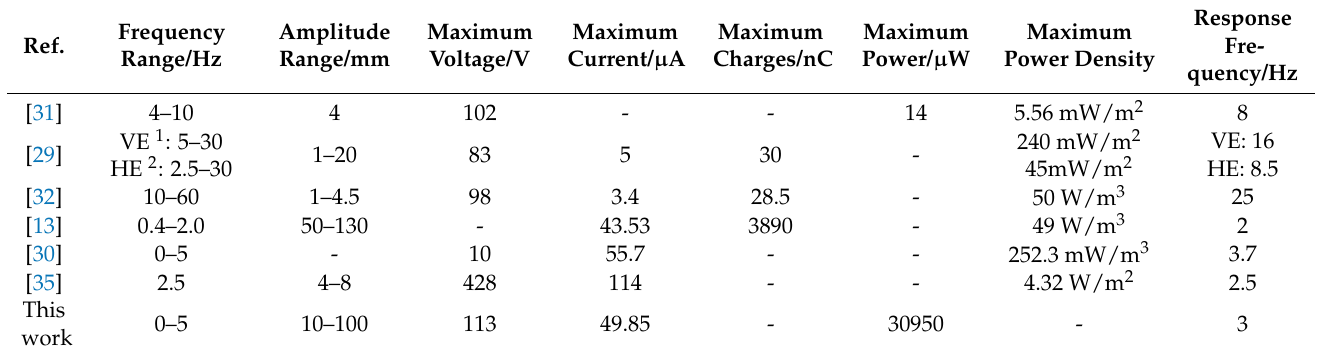
Table 1. The conditions and performance of different TENG-based vibration harvesters.